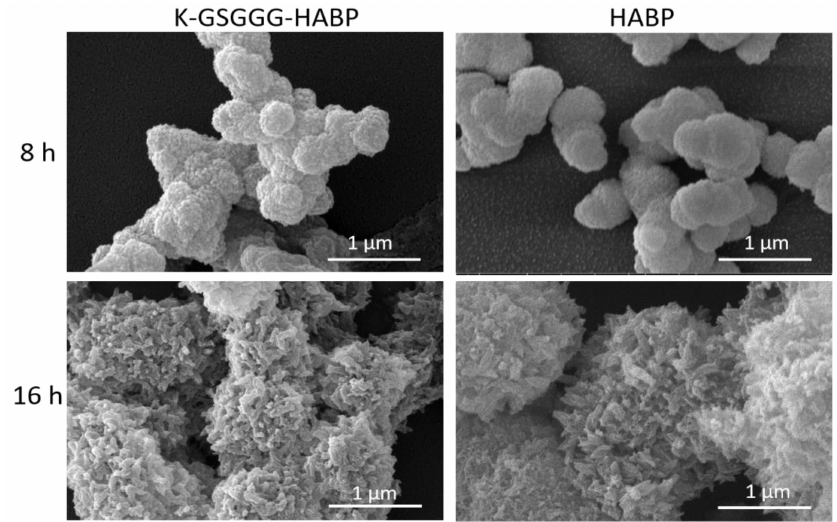
Figure 3. SEM images of the minerals formed in the presence of HABP and